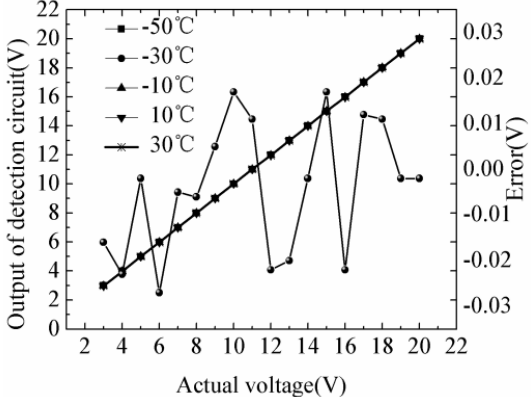
Figure 13. Temperature dependence of the output of detection circuit and the average error.